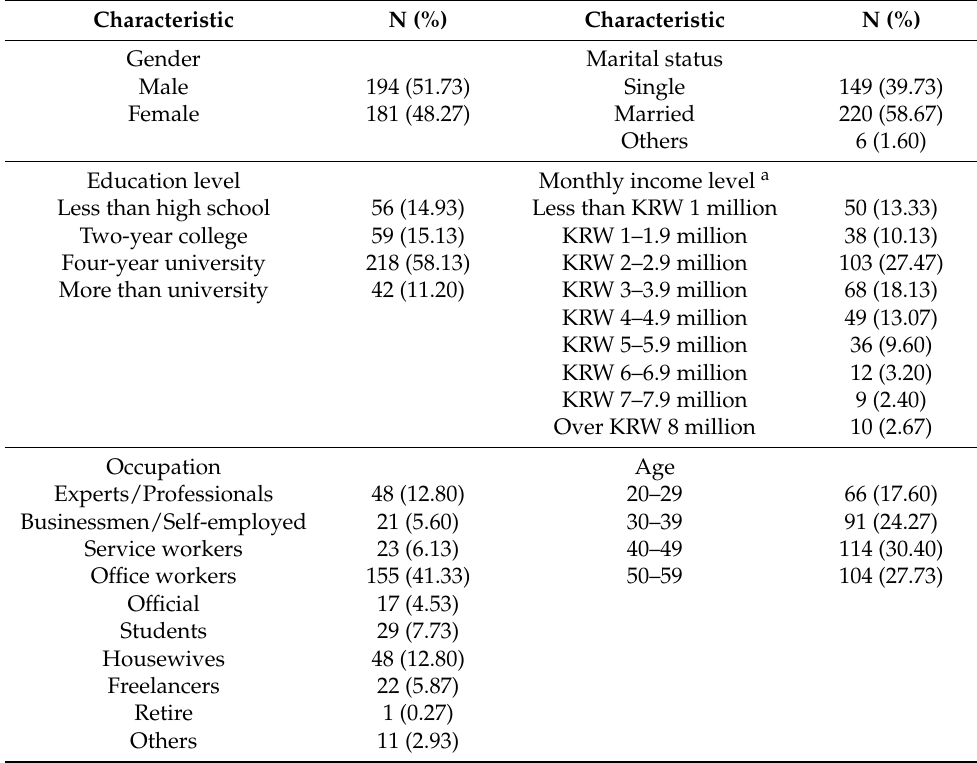
Table 1. Respondents’ demographic characteristics ( n =